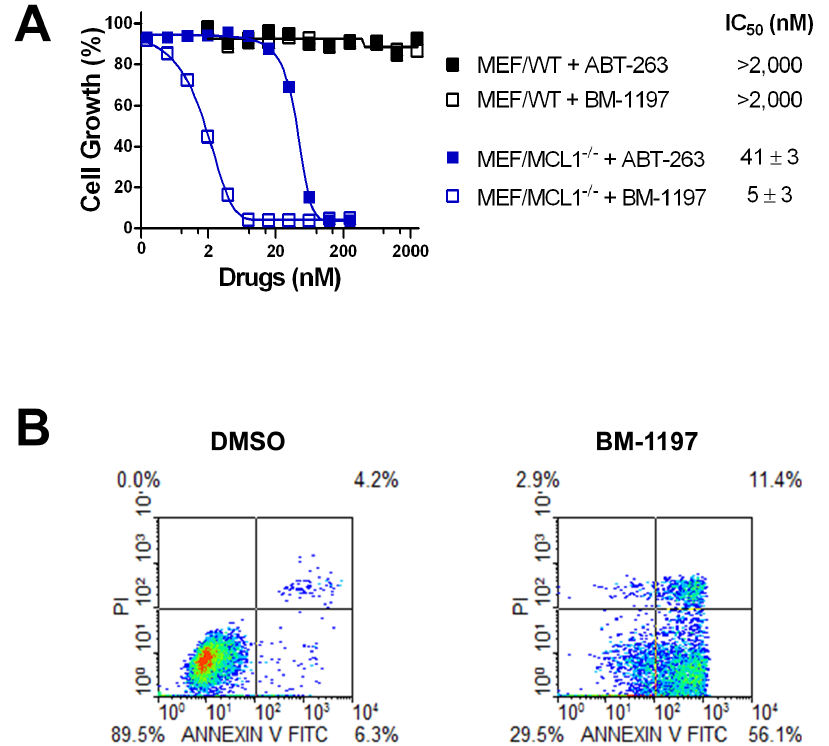
Figure 2. BM-1197 induces apoptosis in MEF/ MCL1 2 / 2 cells. (A) MCL1 -wild-type (WT) or –deficient ( MCL1 2 / 2 ) MEF cells were treated with BM- 1197 or ABT-263 for 3 days and growth-inhibitory activity of BM-1197 was evaluated by WST assay. Data are representative of at least three